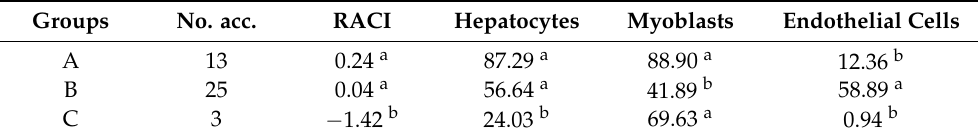
Figure 3. Hierarchical clustering analysis of antioxidant and cytoprotective capacities of whole wheat extracts (WWE). Table 5. Average cluster values of antioxidant and cytoprotective capacities of whole wheat extracts (WWE).